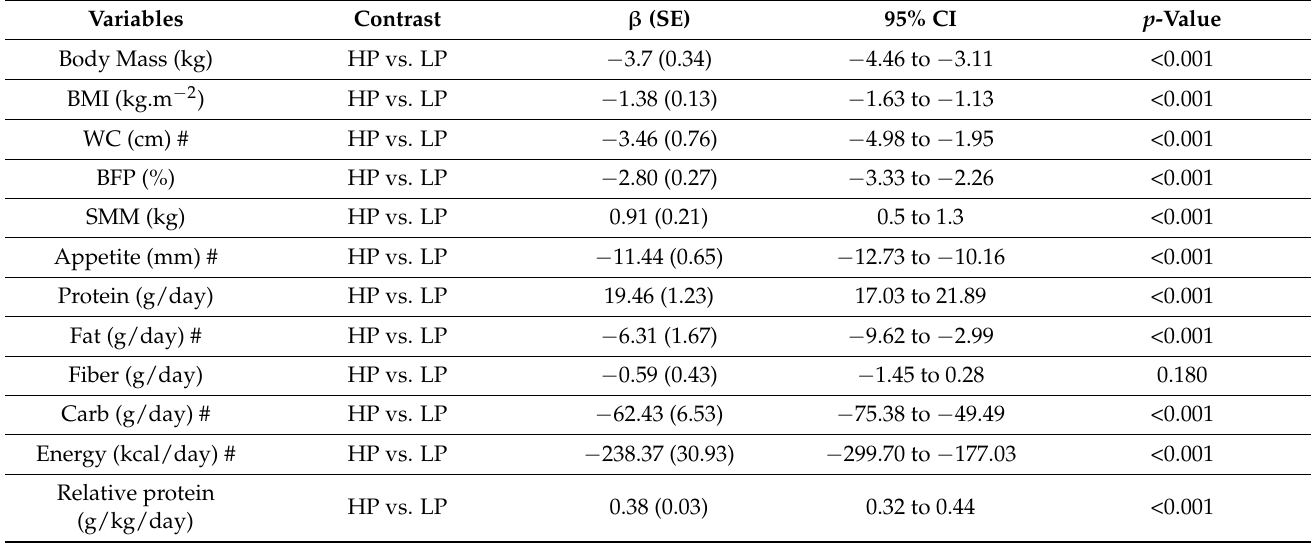
Table 2. The impact of HP vs. LP on